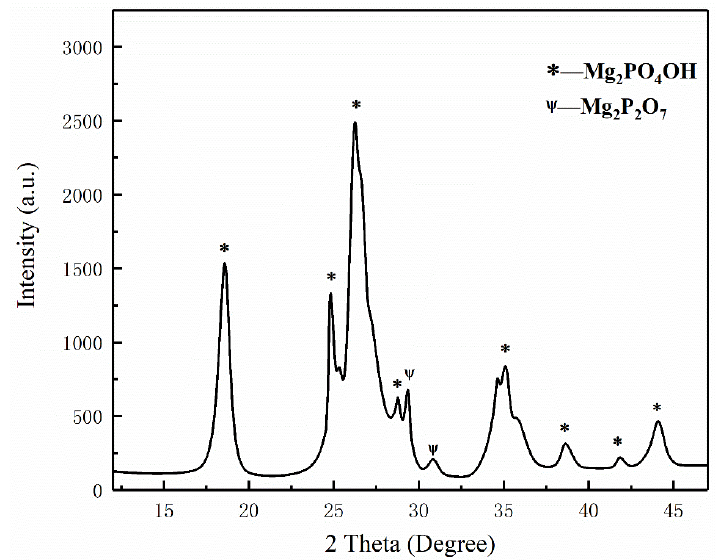
Figure 9. XRD analysis of pyrolysis products of struvite.